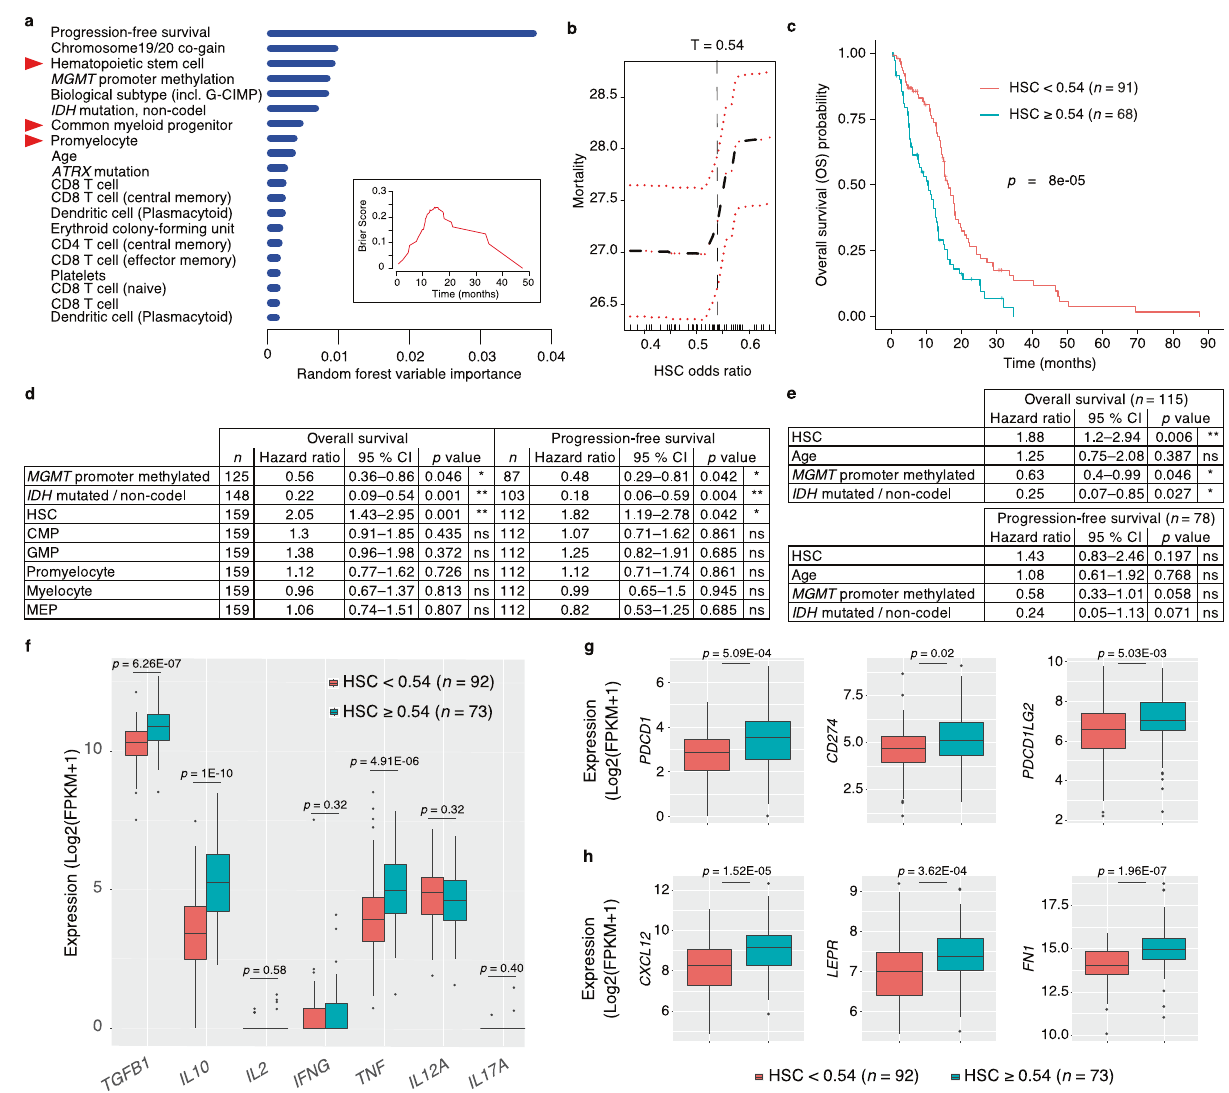
Fig. 6 HSPCs predict clinical outcomes in glioblastoma and associate with an immunosuppressive phenotype and stem cell niche factors. a Bar plot representing the top 20 predictors of glioblastoma overall survival in decreasing order of importance computed by the random forest classi fi er. Red triangles highlight HSPC subsets. Inset, Brier score indicates error rate of random forest classi fi er results as function of survival time (Brier score 0 = 0 % error, 1 = 100% error). MGMT O(6)-Methylguanine-DNA methyltransferase, G-CIMP Glioma CpG island methylator phenotype, IDH Isocitrate dehydrogenase. Source data are provided as a Source Data fi le. b Mortality rate as a function of hematopoietic stem cell (HSC) odds ratios derived by Syllogist and used to determine threshold separating HSC high ( n = 63) and HSC low ( n = 76) patients. Red lines represent 95% CI. c Kaplan – Meier plot of HSC high and HSC low patients using the threshold T = 0.54 selected from ( b ). Two-tailed logrank test. d Univariate Cox regression analysis of selected variables for overall survival and progression-free survival data. e Multivariable Cox proportional hazards model of the HSC subset and potential confounders (Age, MGMT methylation, and IDH mutations) for overall and progression-free survival. In ( d ) and ( e ), we used a two-tailed likelihood-ratio test corrected by the Benjamini – Hochberg procedure. All variables satis fi ed the proportionality hazards assumption (Methods). CMP Common myeloid progenitor, GMP Granulocyte – Monocyte progenitor, MEP Megakaryocyte – Erythroid progenitor. f Boxplots represent the expression of pro- and anti- in fl ammatory cytokines in HSC high ( n = 73) and HSC low ( n = 92) patient samples. TGFB1 Transforming growth factor beta 1, IL10, IL2 Interleukin 10 and 2,